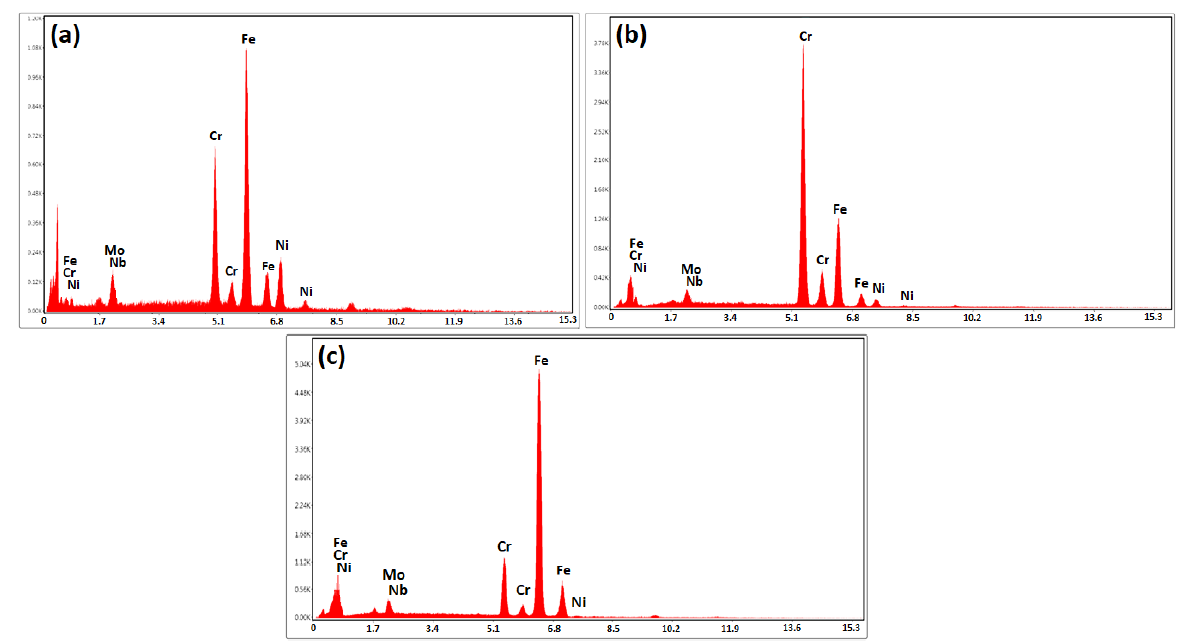
Figure 11. The EDS analysis of secondary-phase precipitations: ( a ) Point A, ( b ) Point B, and ( c ) Point C in Figure 10.